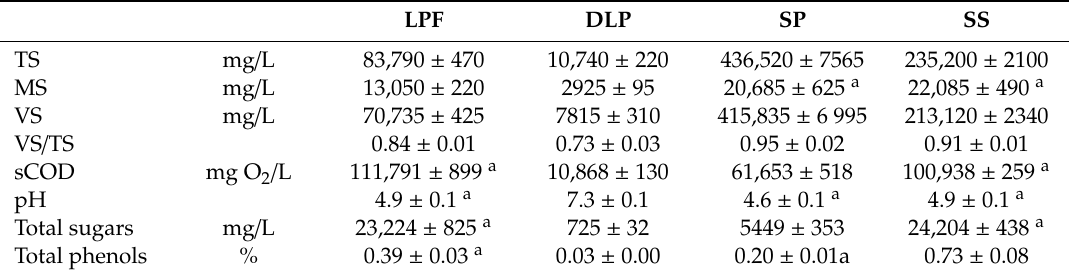
Table 1. Physicochemical characterization of the di ff erent phases obtained.